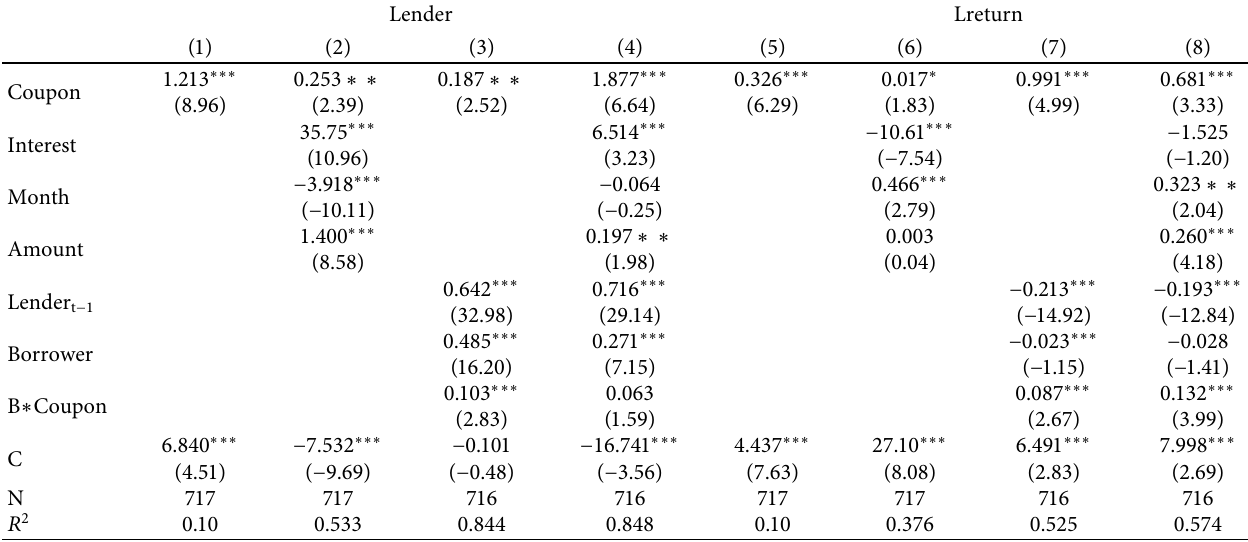
Table 8: The influence of coupon strategy on the number of investors and their return.